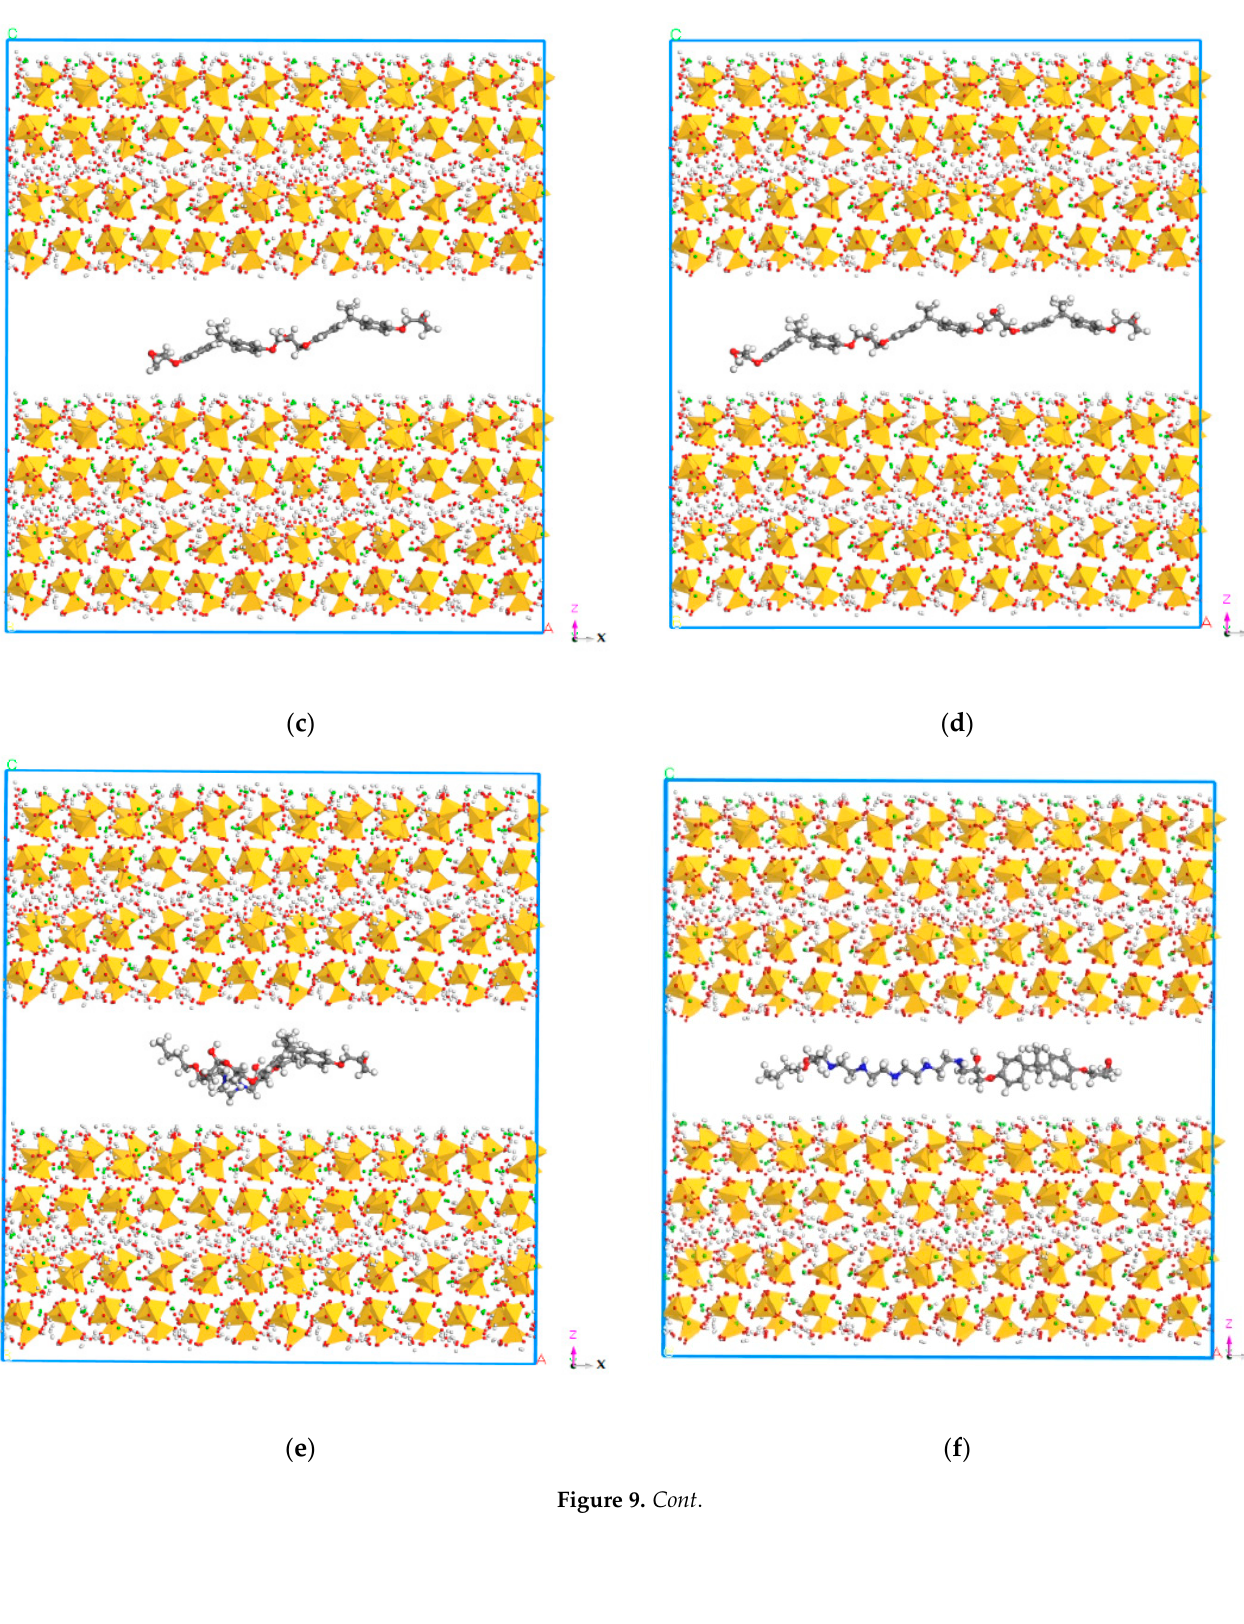
( g ) Figure 9. Molecular structures of the models. ( a ) Molecular structure of model 1. ( b ) Molecular structure of model 2. ( c ) Molecular structure of model 3. ( d ) Molecular structure of model 4. ( e ) Molecular structure of model 5. ( f ) Molecular structure of model. ( g ) Molecular structure of model 7. During the entire MD simulation process, the time step was set as 1 fs and the temperature was fixed at 298 K. The temperature and pressure were monitored and controlled by Nose Thermostat and Berendsen Barostat. Meanwhile, periodic boundary conditions were used [44]. The entire simulation process was divided into two steps. First, the models were relaxed for 1000 ps in the NPT ( N —number of atoms, P —pressure, T — temperature) isothermal–isobaric ensembles, in which the pressure was set to 0 GPa. Second, a further 2000 ps run was conducted in the NVT ( N —number of atoms, V — volume, T —temperature) ensembles to output the result of MD simulation. 3. Results and Discussion 3.1. Structural Analysis